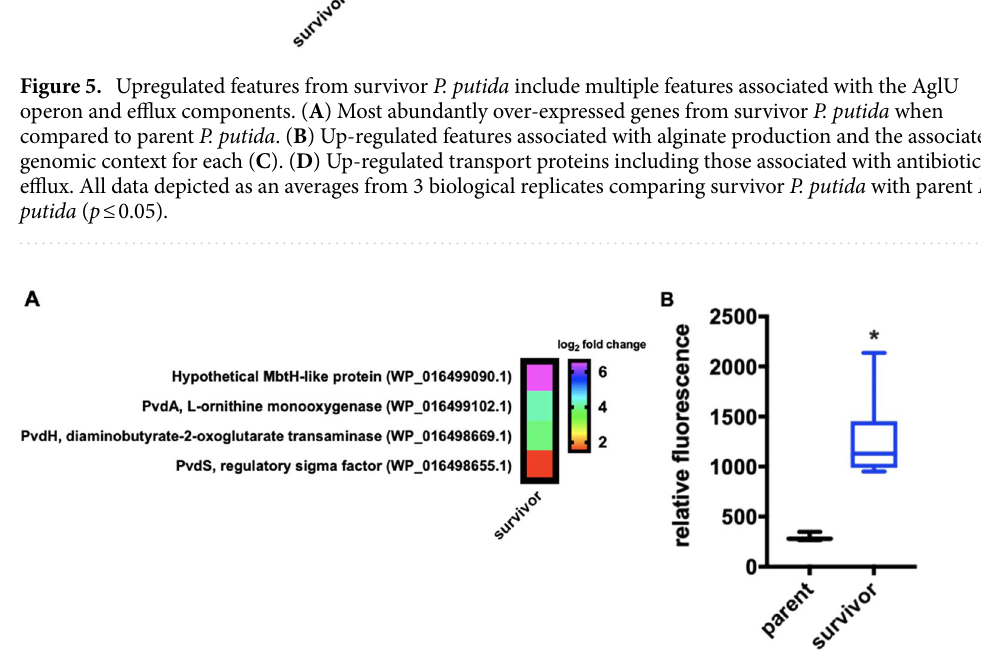
Figure 6. Pyoverdine features up-regulated in survivor P. putida . ( A ) Features associated with pyoverdine biosynthesis up-regulated in the survivor phenotype. Data depicted as an averages from 3 biological replicates comparing survivor P. putida with parent P. putida ( p ≤ 0.05). ( B ) Relative fluorescence of extracellular pyoverdine depicting increased pyoverdine production from the survivor phenotype (n = 12; p ≤ 0.0001). Relative units determined from average of control values